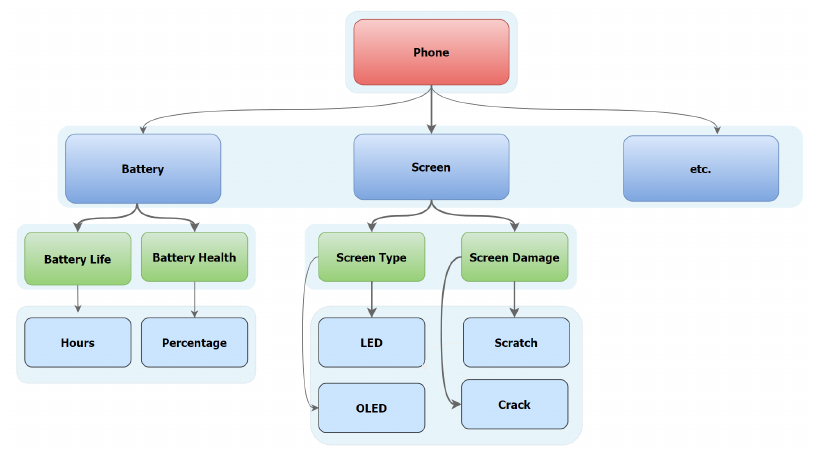
Figure A5. Entity Example for